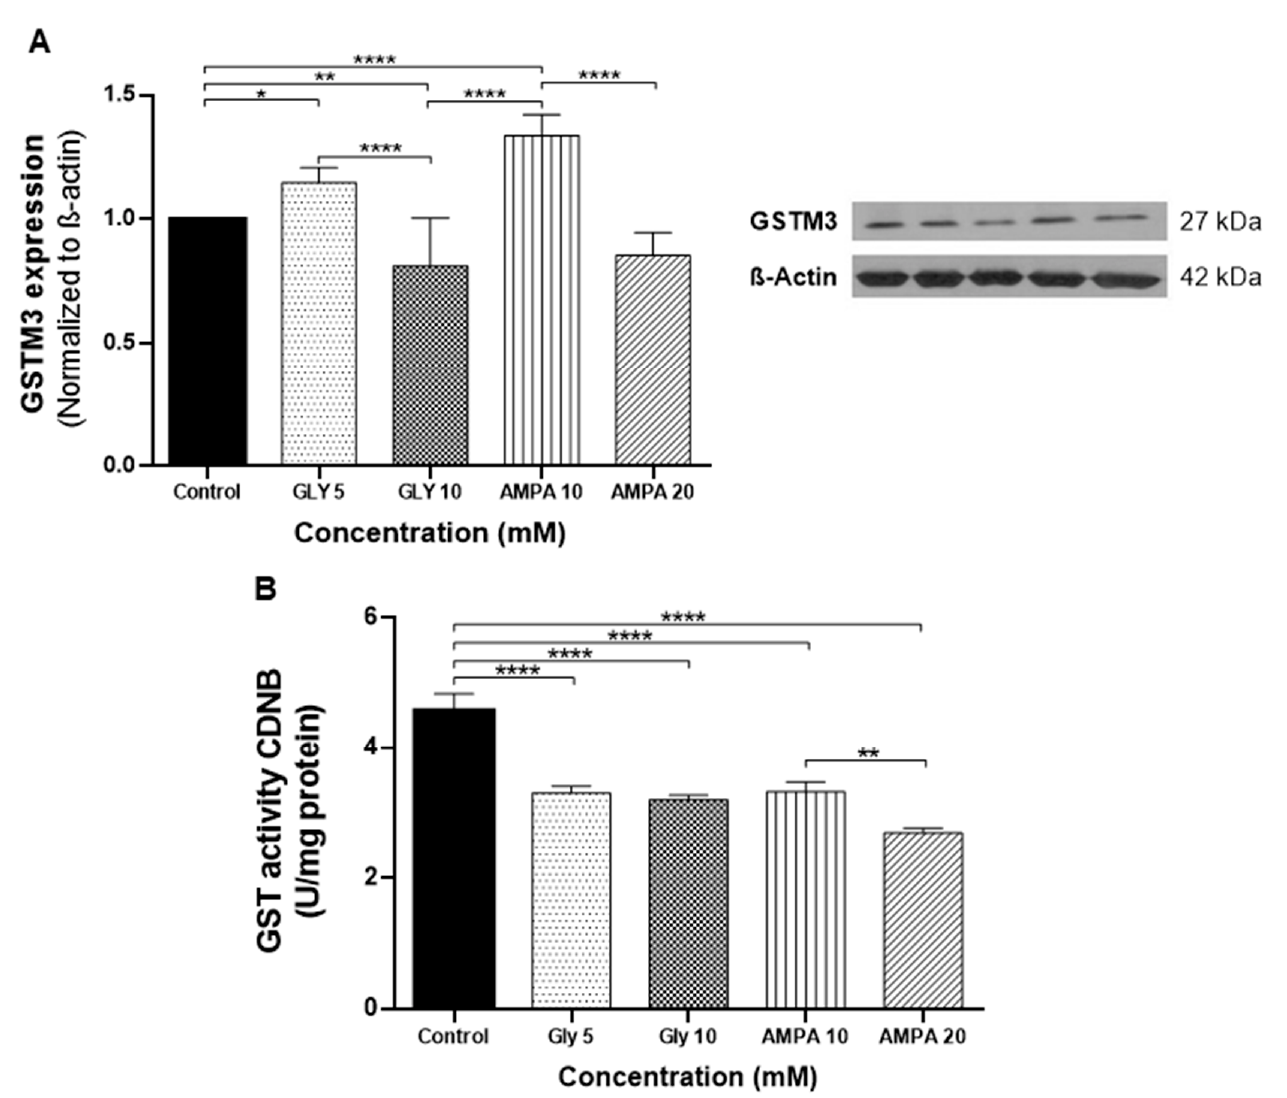
Figure 2. Glutathione S-transferase mu 3 (GSTM3) expression and enzymatic activity in PNT2 (non- tumorigenic) cells treated with glyphosate (GLY) and aminomethylphosphonic acid (AMPA) for 48 h. ( A ) The protein expression levels of GSTM3 were detected using western blotting. β -actin was used as the loading control. ( B ) Enzymatic activity of GST in cell homogenates: 3 µg of protein was analyzed in 0.1 M phosphate buffer, pH 6.5, with 0.1% Triton X-100, 0.1 M reduced glutathione (GSH), and 0.1 M 1-chloro-2,4-dinitrobenzene (CDNB) at 25 °C. Results are expressed as means ± standard deviation of three independent tests performed in triplicate. * p < 0.05, ** p < 0.01, **** p < 0.0001.